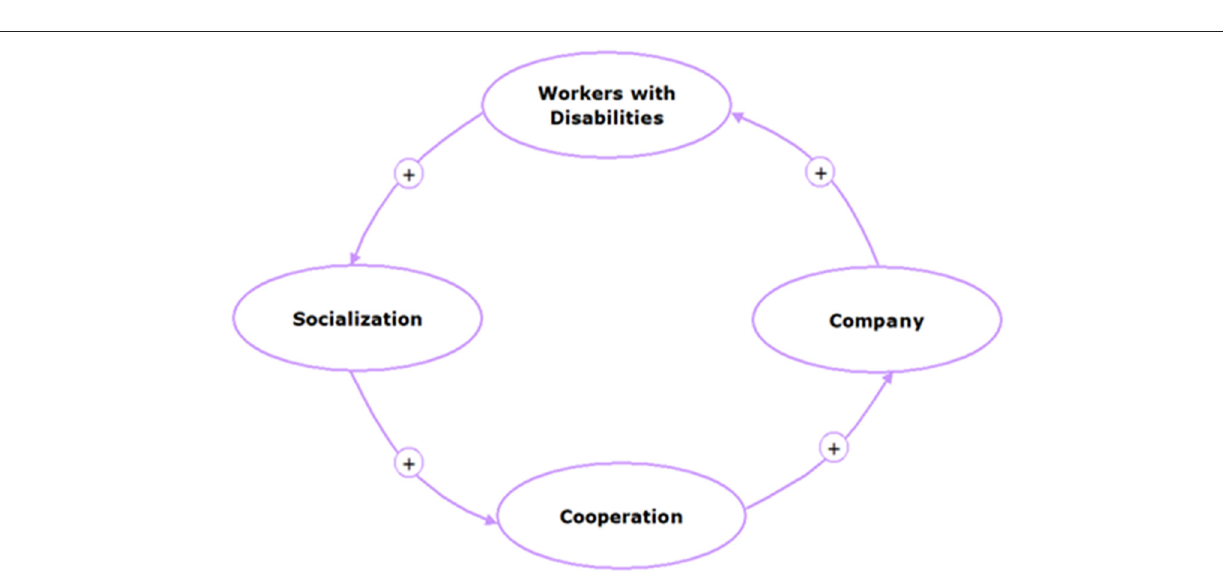
inclusivity as an important factor in choosing an employer (23). Research has also shown that consumers prefer companies that employ individuals with disabilities (24). Various beneficial